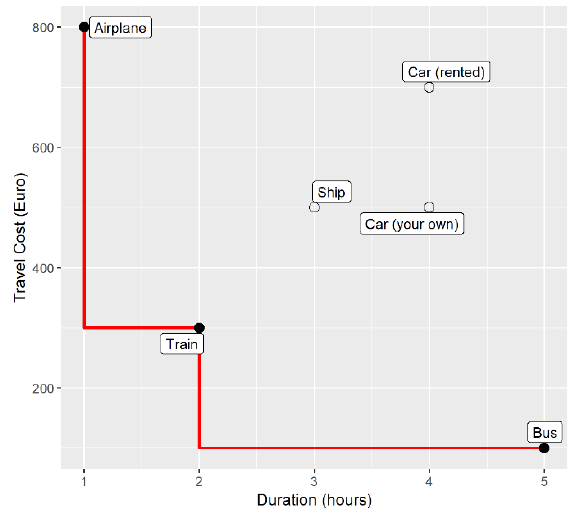
Figure 1. Skyline of the dataset in Table 1.